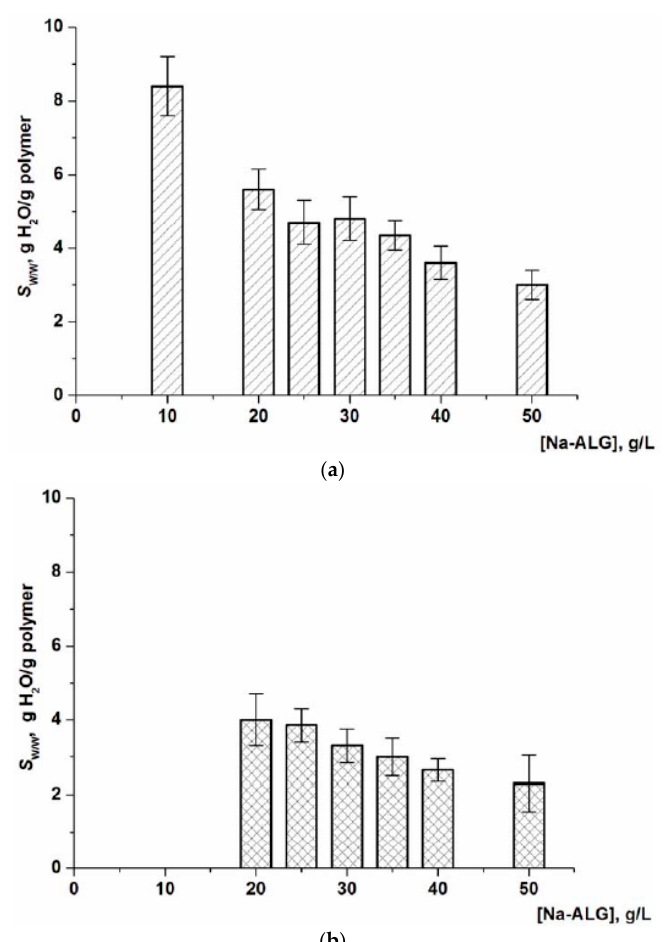
Figure 2. The swelling degree of the polymeric matter in the walls of macropores in Ca-ACRS ( a ) and H-ACRS ( b ) samples formed by freezing at –20 °C of aqueous polymer solutions of different Na-ALG concentrations.